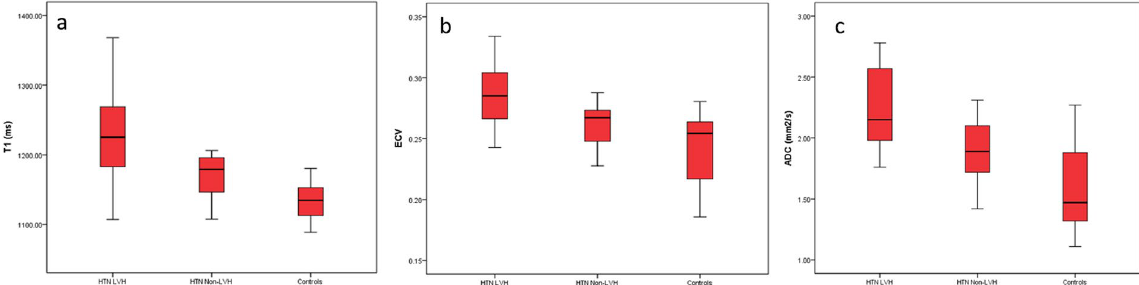
Figure 1. Box plot showing the distribution of Native T1 ( a ), ECV ( b ) and ADC values ( c ) in the 3 study groups. Boxes represent the 25th to 75th percentiles, and horizontal lines within the boxes represent the median